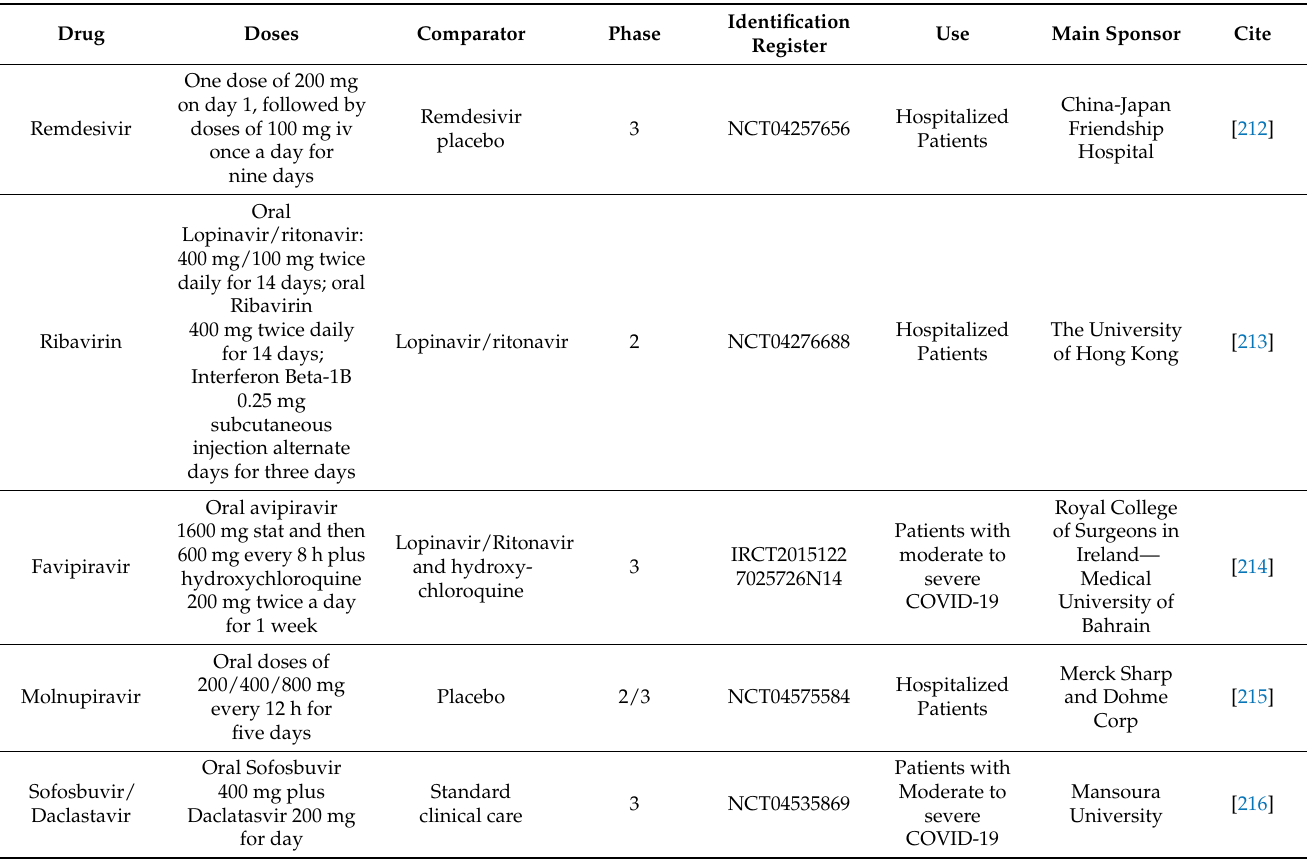
Table 2. Viral polymerase inhibitors against SARS-CoV-2 tested in clinical